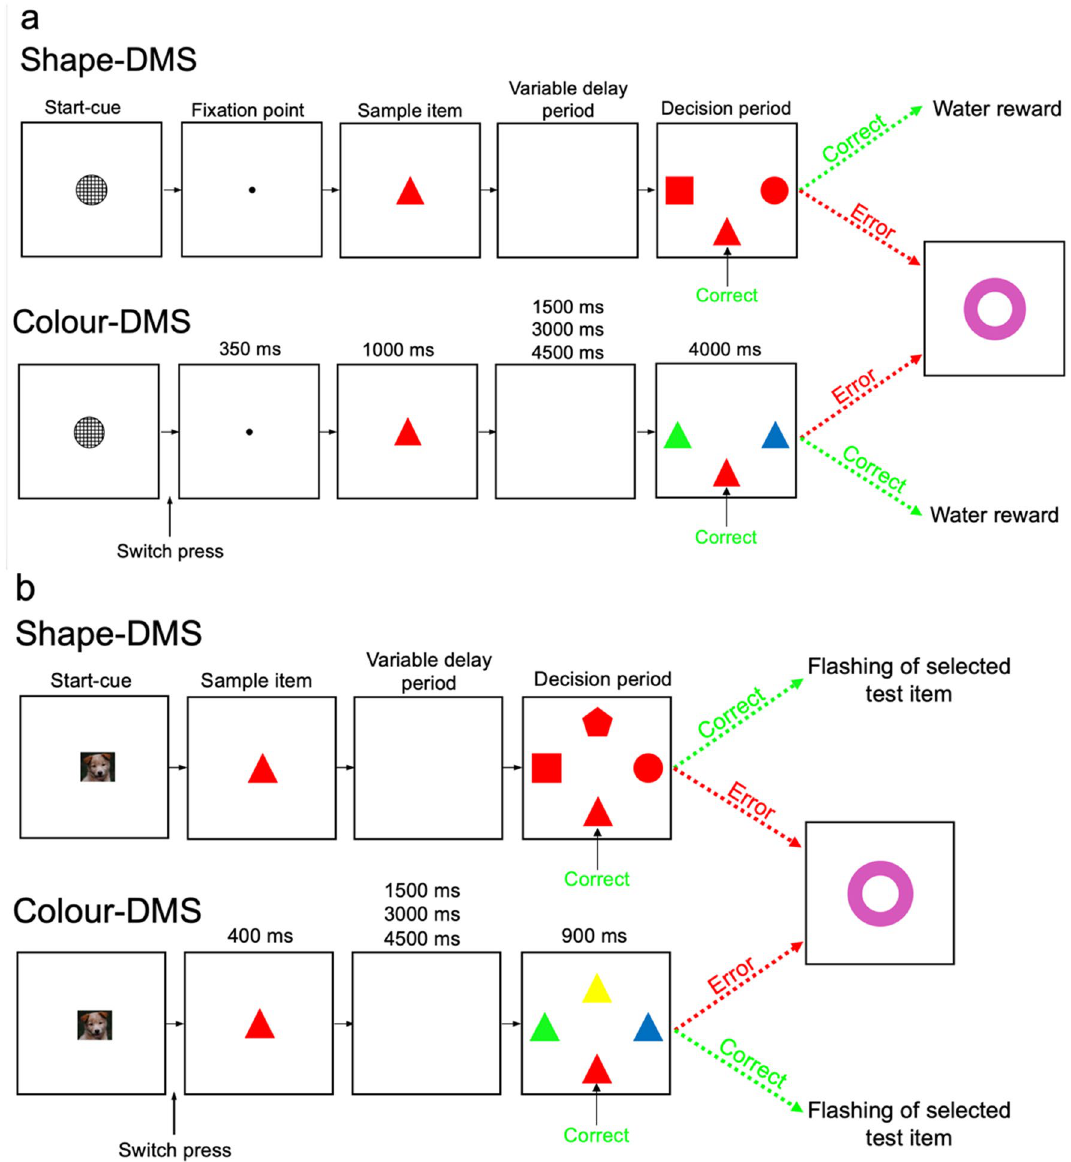
Figure 1. Computerised delayed matching to sample task. ( a ) In the DMS used for testing monkeys, each trial commenced by the appearance of a start-cue (an image), and subjects pressed and held a switch. Pressing the switch changed the start-cue to a fixation point, which was replaced by a sample (coloured shape) if the switch was still held. The sample was shown for 1000 ms before disappearing. Following a delay, the four test items appeared. The delay period randomly varied between 1500 ms, 3000 ms, and 4500 ms. If the correct matching item (target) was selected, feedback was provided (the target item flashed off (for 200 ms) and on (for 200 ms). The selection of the wrong target, early switch release, or failure to respond within the time window (4000 ms) were erroneous responses and led to the disappearance of all items, and an error signal was displayed for 500 ms (pink annulus). In shape-DMS trials, the test items had the same colour as the sample but differed in shape, and therefore the participants were required to match by shape. However, in colour-DMS trials, the test items had the same shape as the sample but differed in colour, and therefore the participants had to match by colour. Shape- and colour-DMS trials were intermingled. In the DMS used in monkeys, three test items were presented on the left, right and bottom of the screen during the matching period. In Experiment 1, the delay was fixed at 1500 ms, while in Experiment 2, the delay was randomly varied (1500 ms, 3000 ms, or 4500 ms). Upon selection of the correct target, the monkeys received a liquid reward (water). ( b ) In the DMS used in humans, the trial structure was similar, however, four test items were presented on the left, right, top and bottom of the screen during the matching period (900